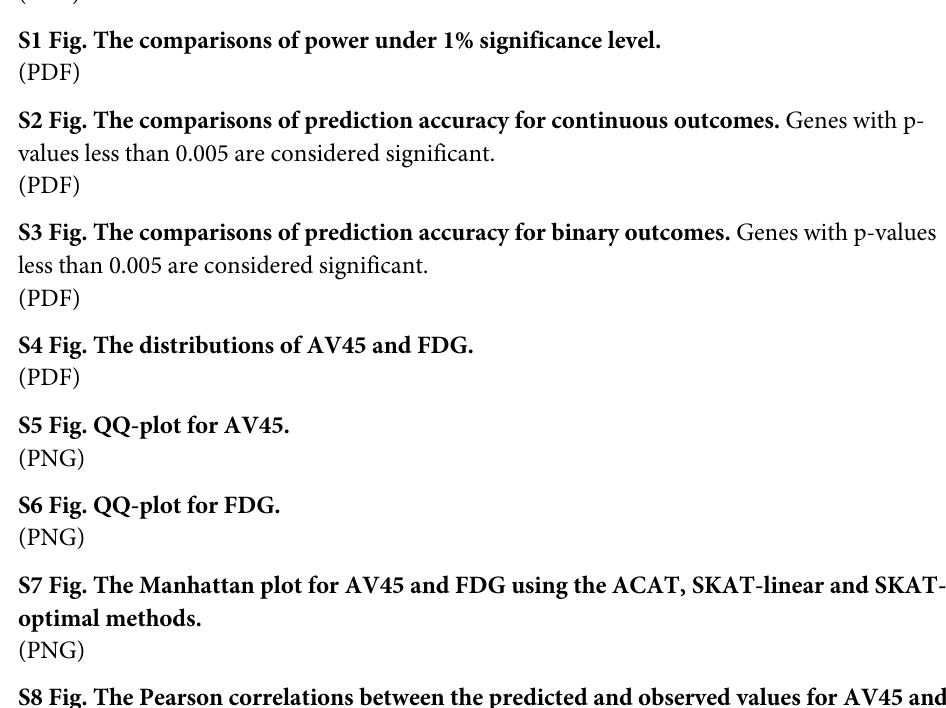
S3 Table. The probability of genes being selected for AV45. (PDF) S4 Table. The probability of genes being selected for FDG. (PDF) S1 Fig. The comparisons of power under 1% significance level. (PDF) S2 Fig. The comparisons of prediction accuracy for continuous outcomes. Genes with p- values less than 0.005 are considered significant. (PDF) S3 Fig. The comparisons of prediction accuracy for binary outcomes. Genes with p-values less than 0.005 are considered significant. (PDF) S4 Fig. The distributions of AV45 and FDG. (PDF) S5 Fig. QQ-plot for AV45. S6 Fig. QQ-plot for FDG. (PNG) S7 Fig. The Manhattan plot for AV45 and FDG using the ACAT, SKAT-linear and SKAT- optimal methods. S8 Fig. The Pearson correlations between the predicted and observed values for AV45 and FDG. Genes are pre-selected under the p-value threshold of 0.005 for DNN-transfer, SKAT- linear, SKAT-optimal and ACAT. S9 Fig. The average computational resources for feature screening as sample sizes increase (n = 2000, 4000, 6000, 8000, 10000, 50000, and